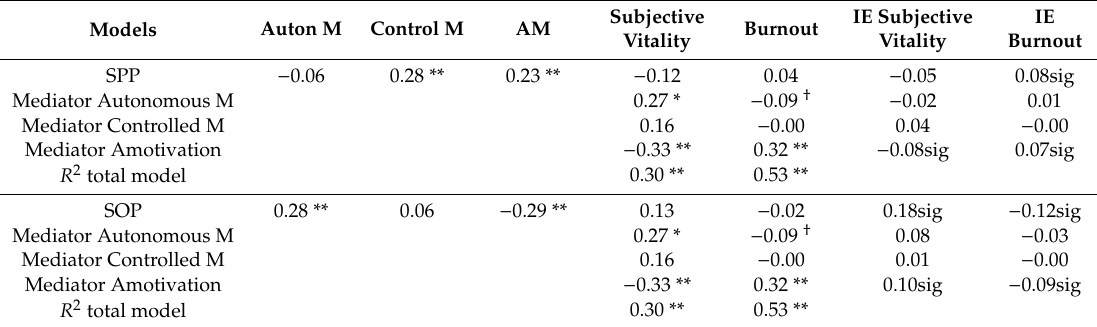
Table 2. Mediational e ff ects of forms of motivation and amotivation in the relationship between dimensions of perfectionism and well-ill being.